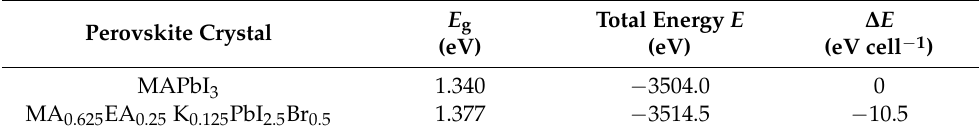
Table 3. Calculated energy gaps and difference of total